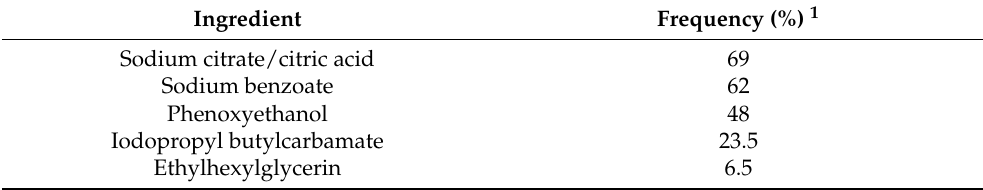
Table 6. Preservative ingredients commonly found in baby wipes in 2019, adapted from [117]. Ingredient Frequency (%)